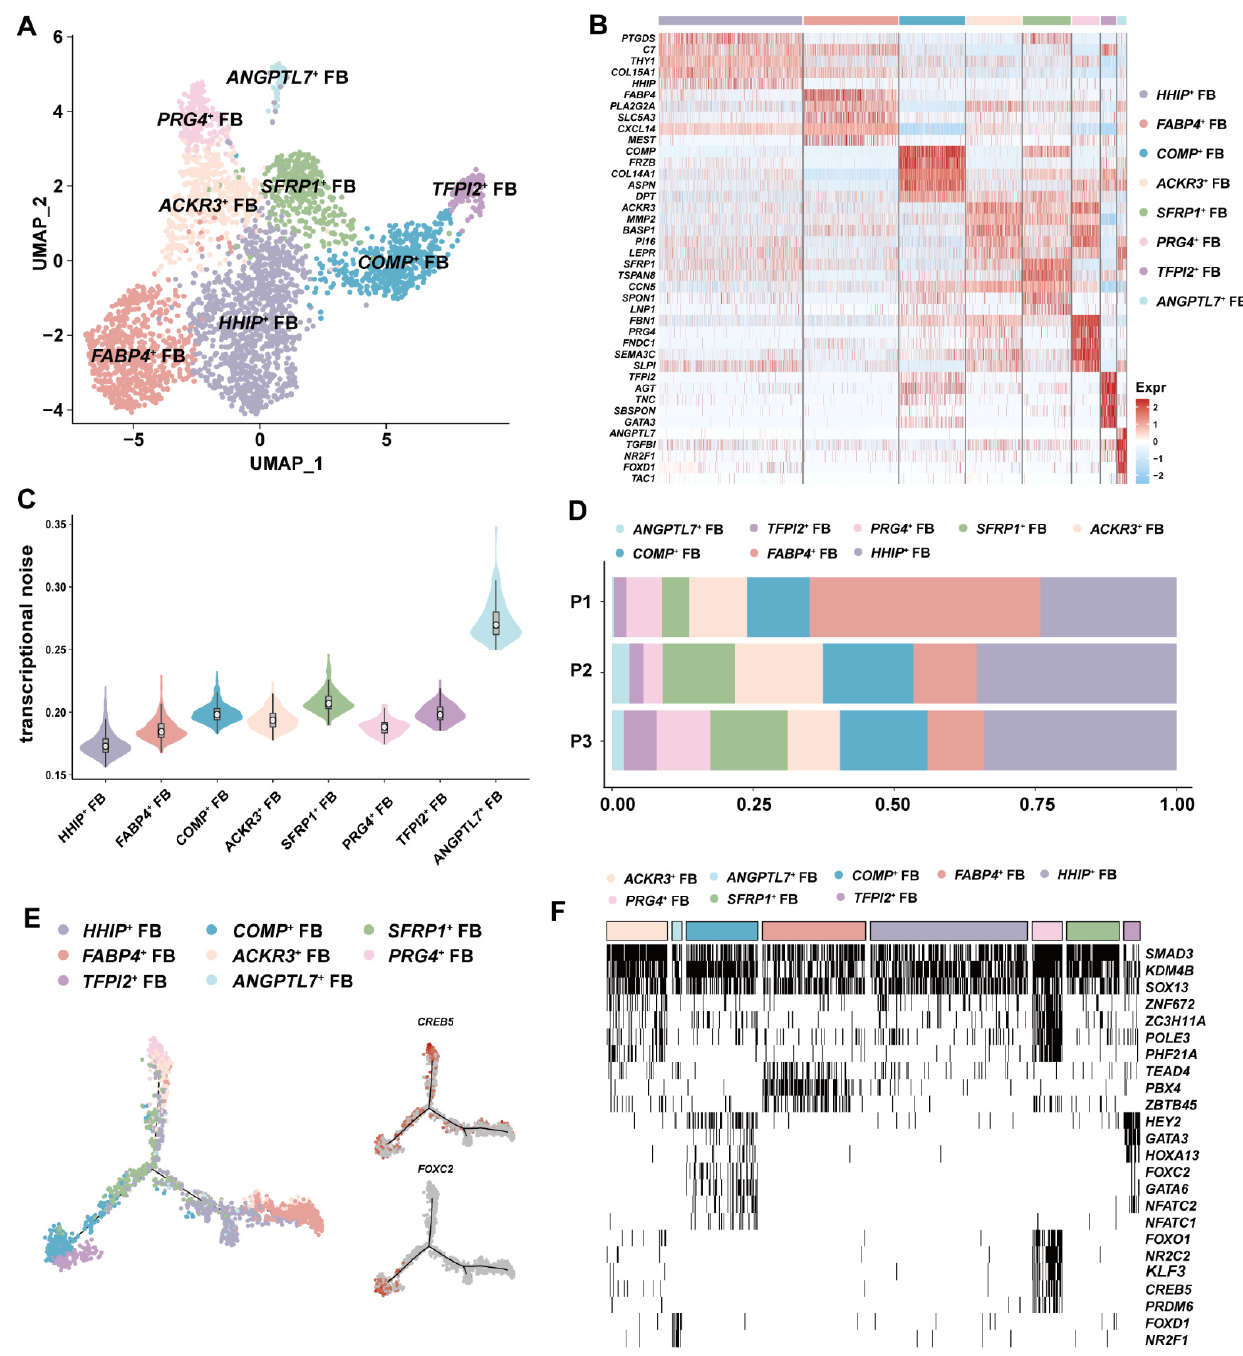
Figure 3. Fibroblast heterogeneity in human GSVs. ( A ) The UMAP plot showing all FB cell subsets. ( B ) Heatmap showing the signature genes for each FB subset. ( C ) Transcriptional noise analysis showing that ANGPTL7 + FBs had the most variable expression patterns, reflecting a highly heterogenous nature in gene expression. ( D ) Cell ratio comparison identifying that ANGPTL7 + FBs were enriched in patient P2. ( E ) Pseudo-time analysis revealing that the connection of FB cell subsets was line with their spatial distribution. CREB5 regulated valvular FB development and FOXC2 impacted on lymphatic FB. ( F ) Identification of cell-subset-specific regulon by SCENIC. The regulons of SMAD3 , KDM4B and SOX13 were universally switched on in all FB subsets.